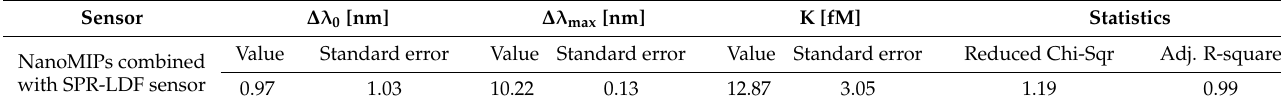
Table 1. Langmuir parameters of HTR detection in buffer solution.